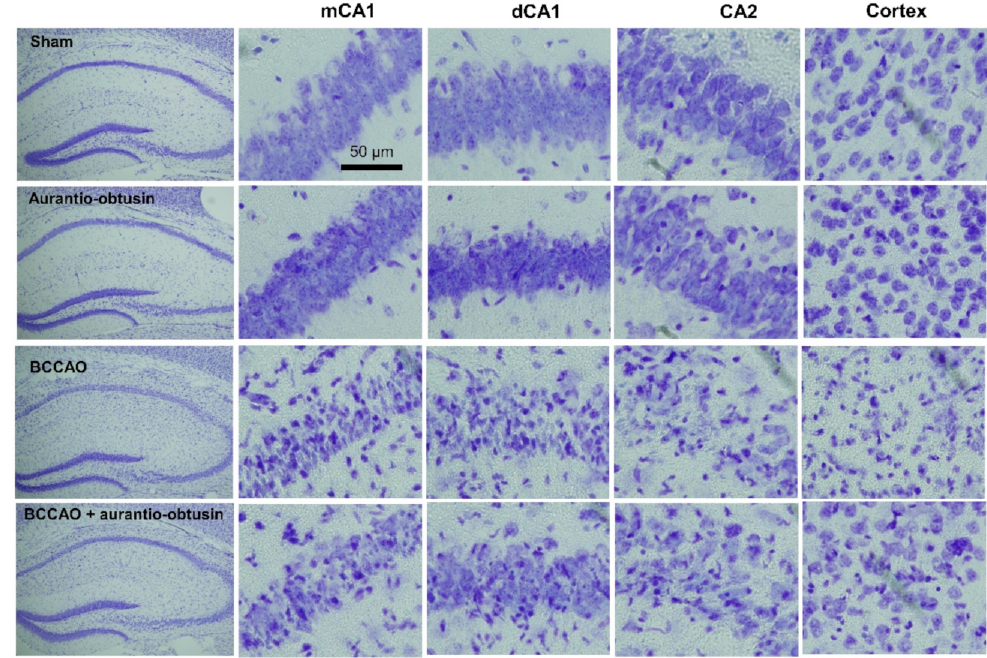
Figure 5. Photomicroscopes of Nissl staining showing degree of transient forebrain ischemia-induced neuronal damage in different brain